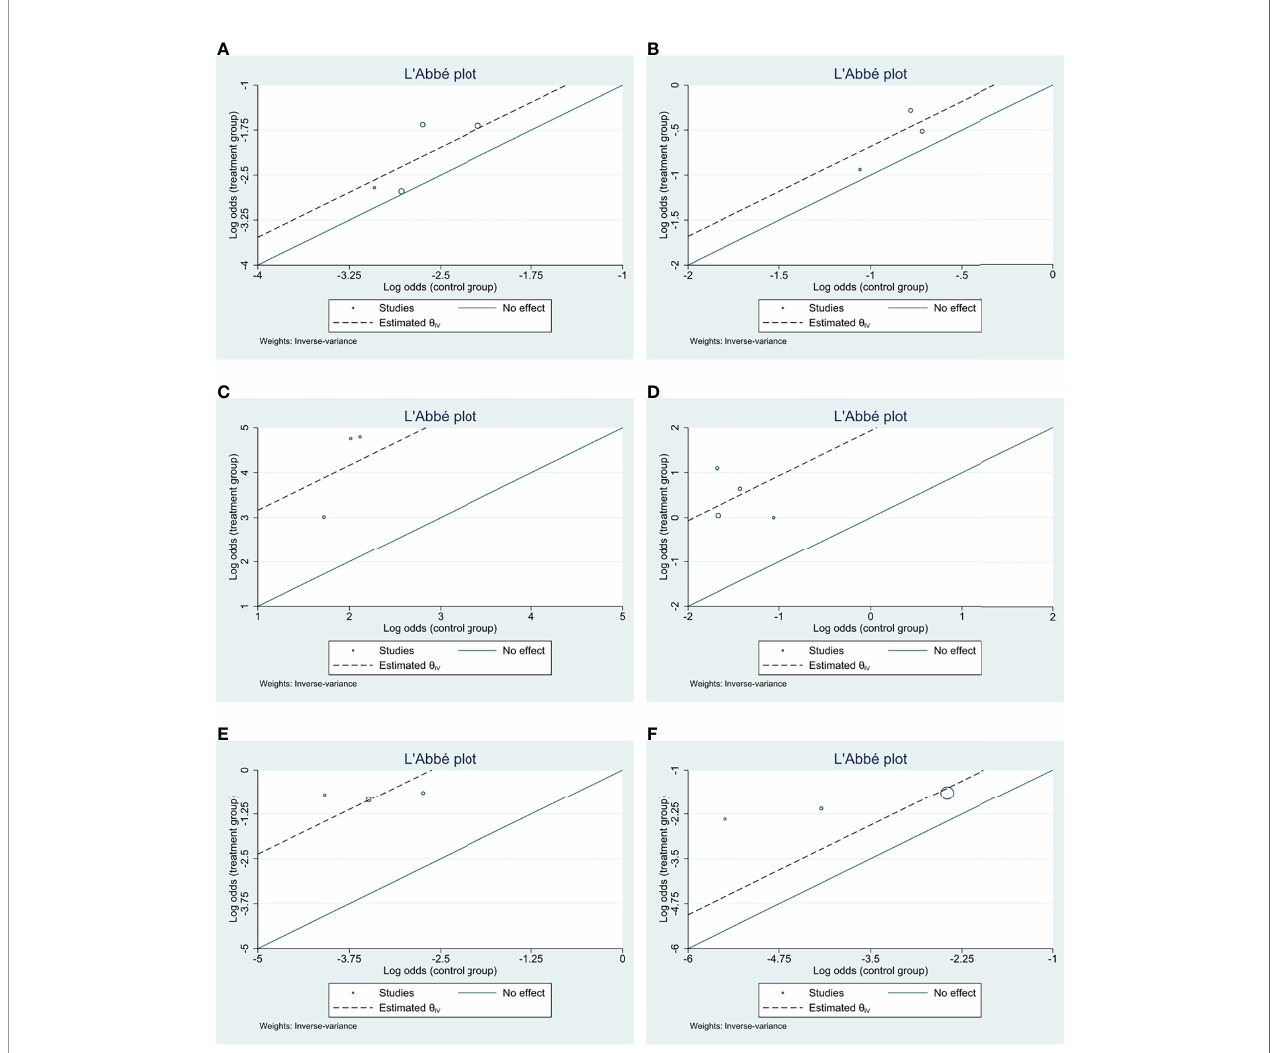
FIGURE 4 | L ’ Abbe ́ plots for ef fi cacy and AE endpoints of included studies. (A) ORR; (B) CBR; (C) all AE; (D) Grade ≥ 3 AE; (E) dose modi fi cation due to AE; (F) treatment discontinuation due to